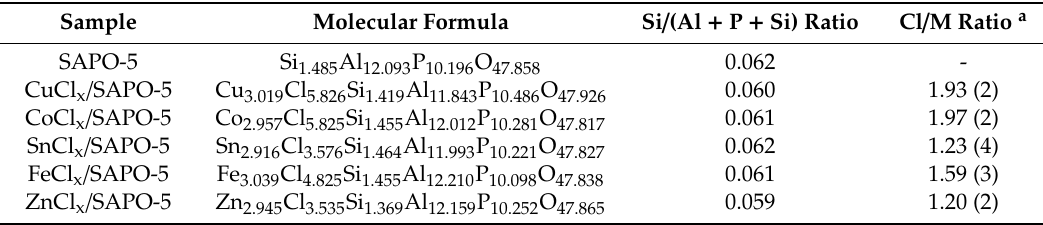
Table 2. Calculated molecular formulae and elemental ratios of metal chlorides supported on SAPO-5. Sample